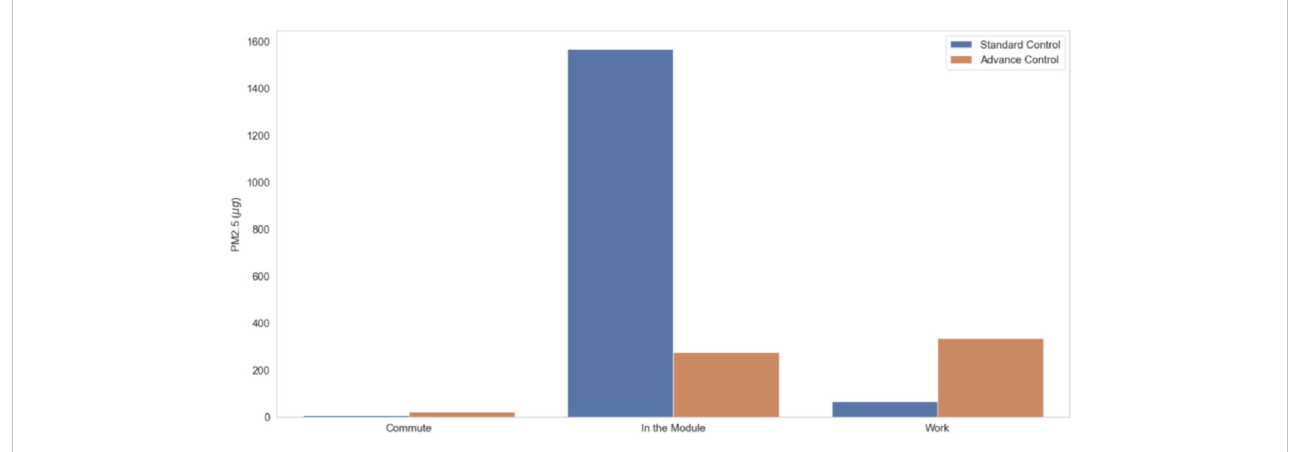
FIGURE 8 Integrated concentration during the commute, stay in the residential module and at work for standard and advanced control modules.